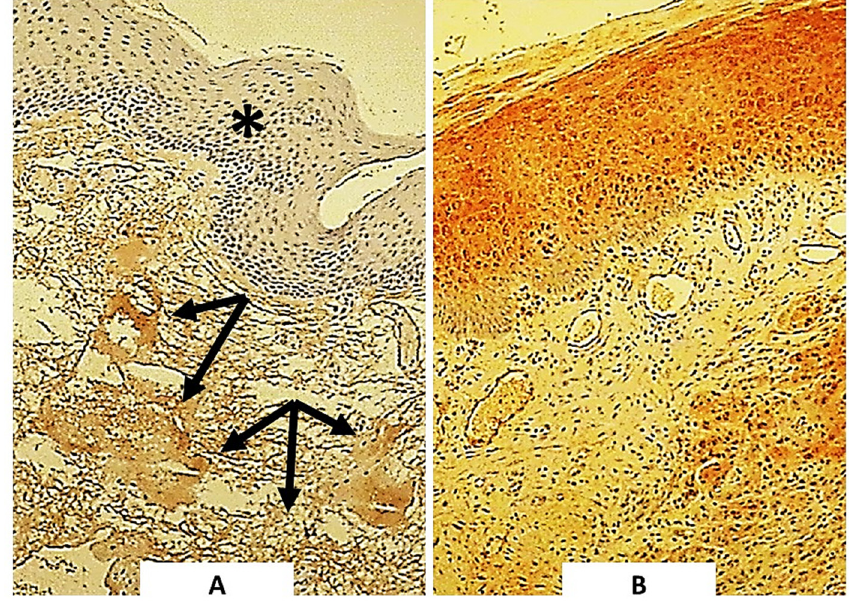
Figure 3. The immunohistochemical appearance of HNE in normal, healthy oropharyngeal mucosa. ( A ) No HNE can be seen in the normal epithelium of the healthy subject (indicated by asterisk), although adjacent stromal tissue contains HNE (indicated by arrows). ( B) Prominent presence of HNE in non-malignant epithelium in the vicinity of squamous cell carcinoma grade III of the oropharynx. Table 2. The presence of HNE-immunopositivity in non-malignant tissue cells within / near tumor. HNE-Positivity N